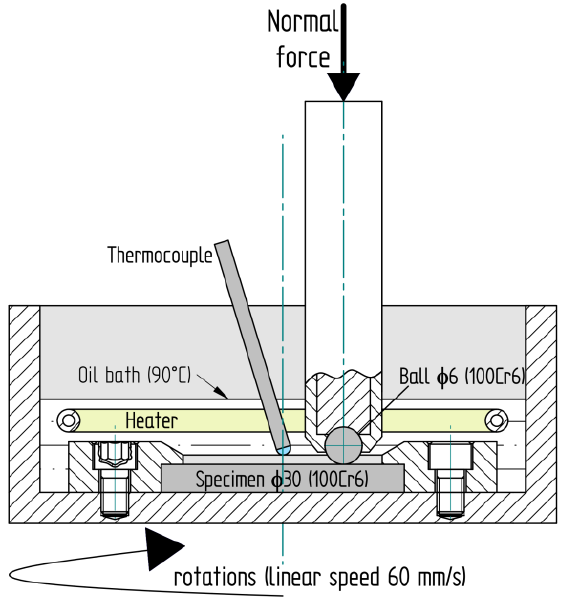
Figure 1. Picture of the tribometer test set up for the lubricating oil tests.